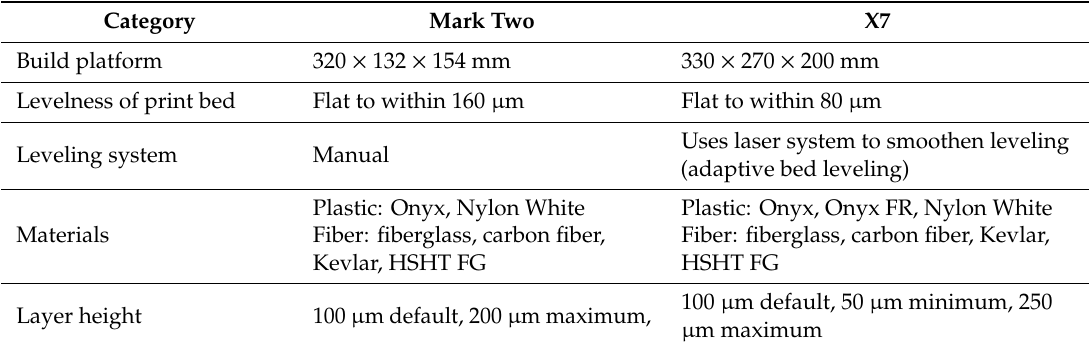
Table 4. Di ff erences between the Markforged advanced desktop (Mark Two) vs. industrial series (X7) printers